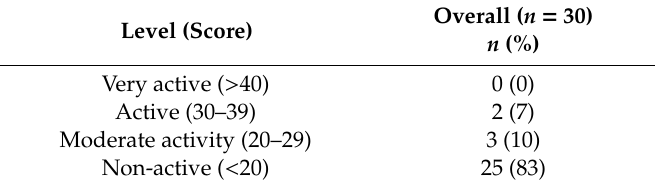
Table 4. Assessment of physical activity of the polypectomy patients ( n = 30; male = 14, female = 16) . Overall ( n = 30) Level (Score) n (%)